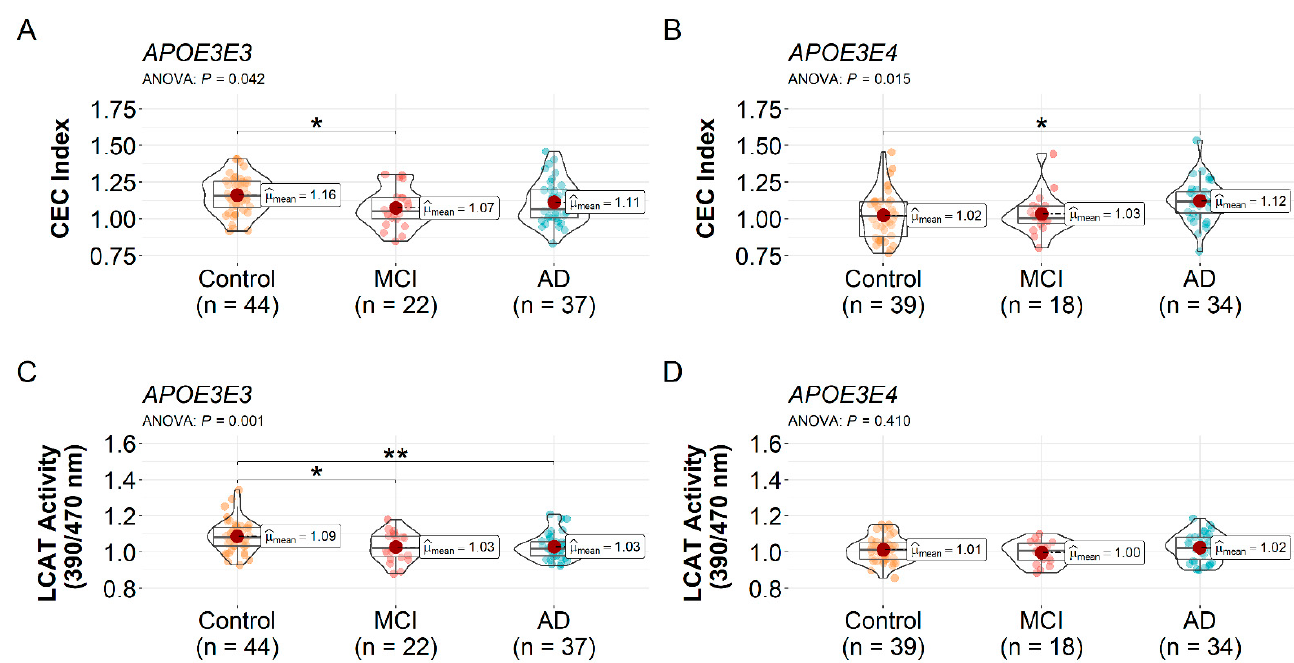
Figure 2. APOE -specific alteration in the HDL CEC index and LCAT activity amongst the control, MCI, and AD participants. The HDL CEC index within the ( A ) APOE3E3 and ( B ) APOE3E4 carriers by diagnosis. Decrease of LCAT activity in ( C ) APOE3E3 patients but not ( D ) APOE3E4 patients. One-way ANOVA followed by Tukey’s multiple comparison tests was used. * p < 0.05 and ** p < 0.01 . Abbreviations: AD = Alzheimer’s disease dementia, CEC = cholesterol efflux capacity, HDL = high-density lipoproteins, LCAT = lecithin-cholesterol acyltransferase, MCI = mild cognitive impair- ment.